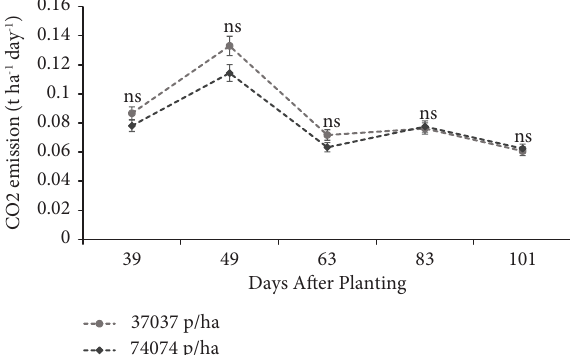
Figure 10: CO 2 emission rate in low and high density of cowpea at Ofcolaco during the 2020/21 cropping season. ns